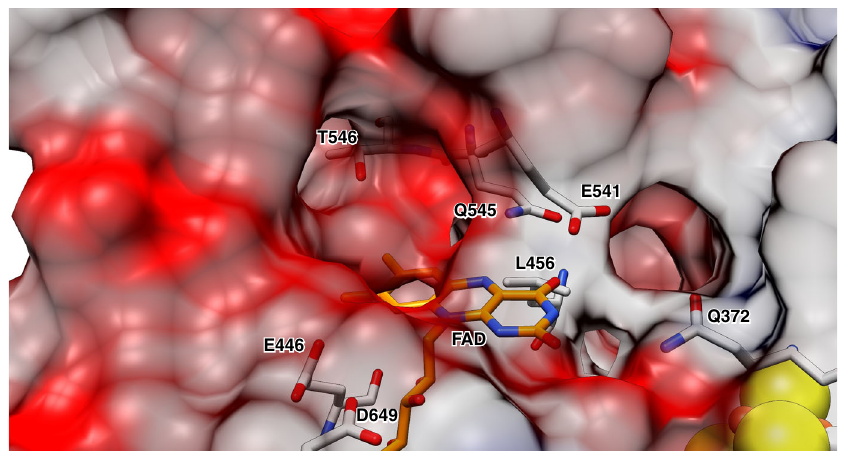
Fig. 3 Binding of the FAD cofactor. Anionic/polar residues responsible for the negative electrostatic potential are indicated. Several hydrophobic side chains around the isoalloxazine preferably stabilize the uncharged FAD and FADH (cid:129)